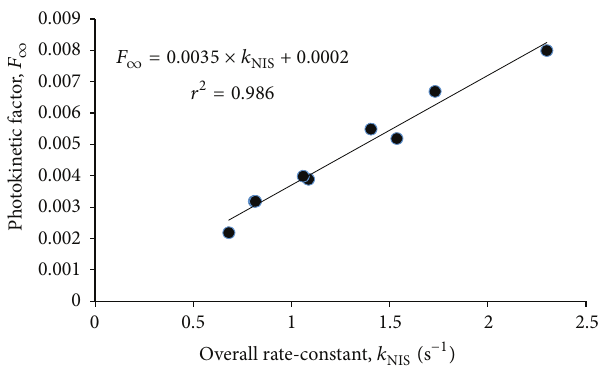
Figure 9: Linear correlations between the parameters of the traces ] 320/390 𝑃 𝑗 𝑘 320 320 for NIS in 0,𝑗 against the radiant power, NIS ,𝑗 and